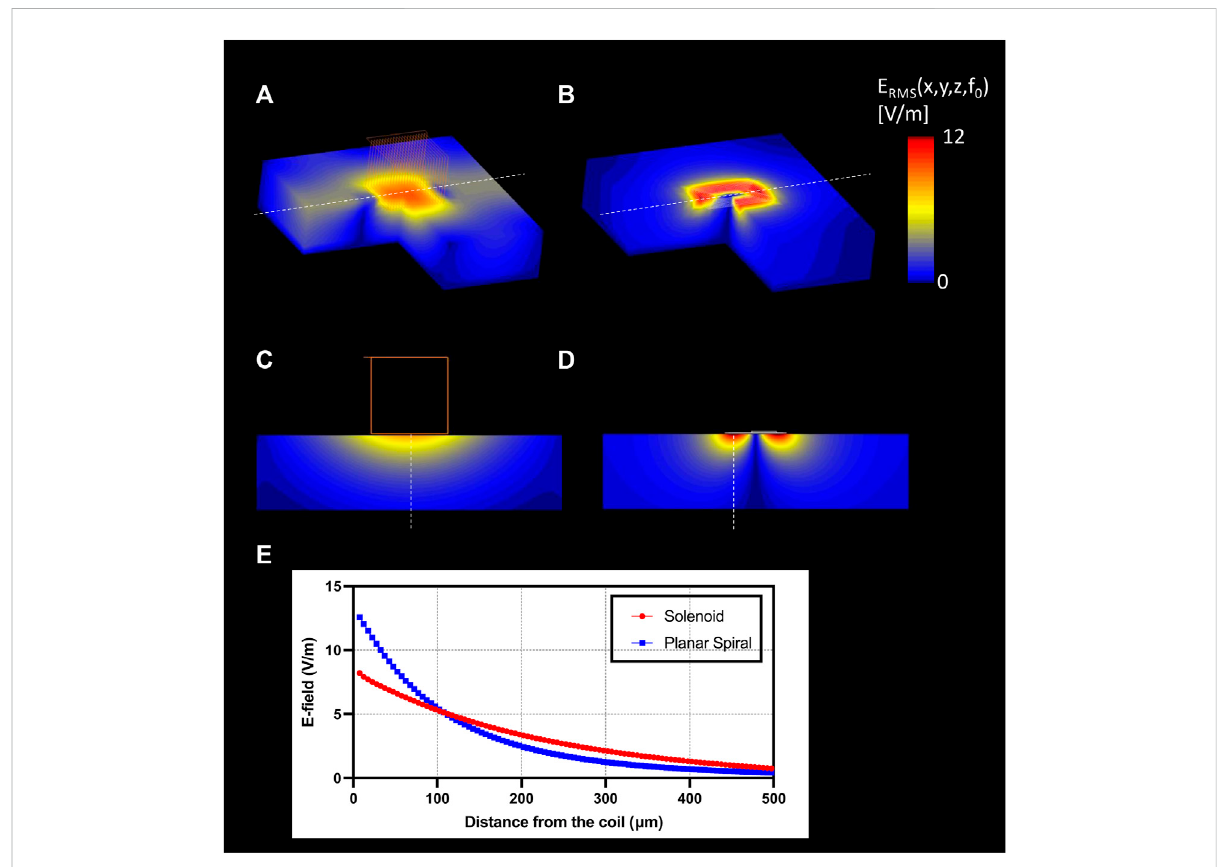
FIGURE 5 EM simulation results. 3D surface view of the E- fi eld generation on the nerve with (A) solenoidal coil (21 turns, wire diameter: 7 µm); (B) planar spiral coil (8.5 turns, trace width: 7 µm); Slice view of the E- fi eld penetration in the central view with (C) solenoid coil, (D) planar spiral coil; (E) pro fi le of the |E|RMS (blue), and gradient of |E|RMS (red) along with the maximum E- fi eld projection (red: solenoid coil, blue: planar spiral